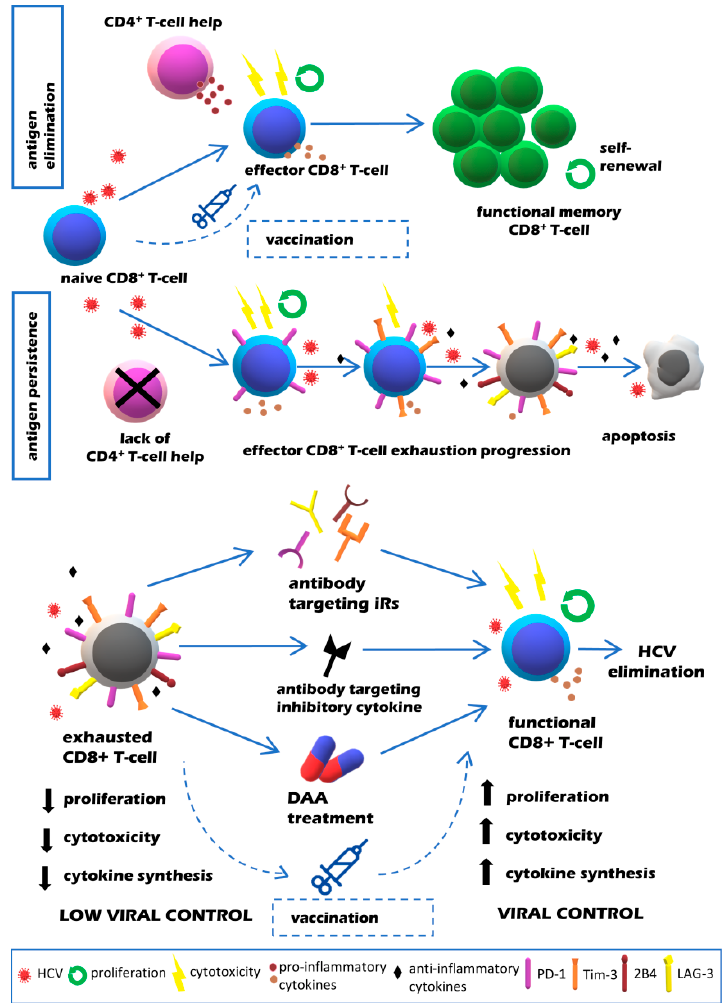
Figure 1. Quality of CD8 + T cell responses in resolving vs . chronic HCV infection (upper panel) and potential strategies aimed at restoration of exhausted T cell function in chronic HCV infection (lower panel).